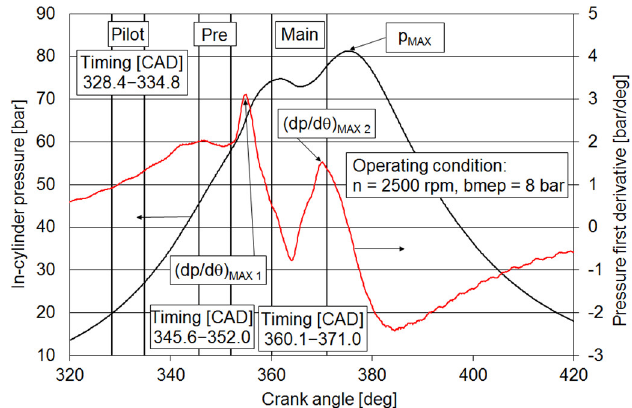
Figure 2. Example of an in-cylinder pressure diagram, the curve of the pressure first derivative and related parameters.